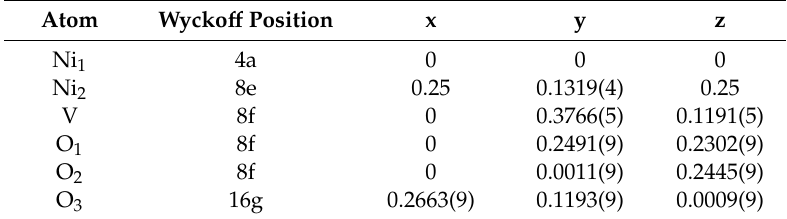
Figure 2. Background subtracted ambient-conditions powder X-ray diffraction (XRD) pattern measured in Ni 3 V 2 O 8 using Cu K α 1 . Experiment: black dots, Rietveld refinement: red line, residual: black line. Ticks indicate the position of peaks. The most intense peaks have been labeled with the corresponding Bragg planes. Table 1. Fractional coordinates of atoms in the crystal structure of Ni 3 V 2 O 8 .